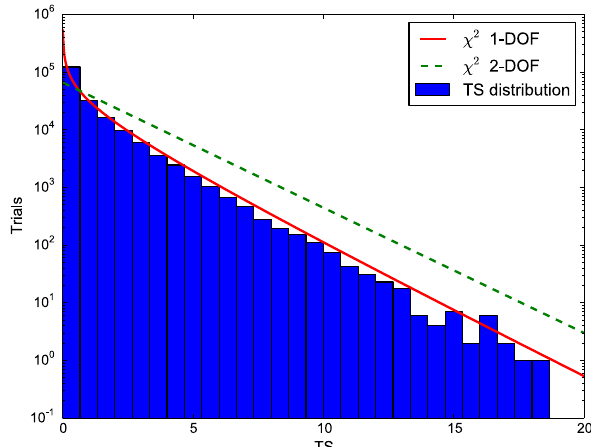
Fig. 4 Distribution of the test statistics for O ( 10 7 ) number of exper- imental measurements of the number of events for true values of the phases (δ,φ 1 ) = ( 0 , 0 ) for IH and (γ,θ, M 1 ) = ( 3 . 5 , 0 , 1 ) GeV, com- pared to the χ 2 distribution for 1 or 2 degrees of freedom